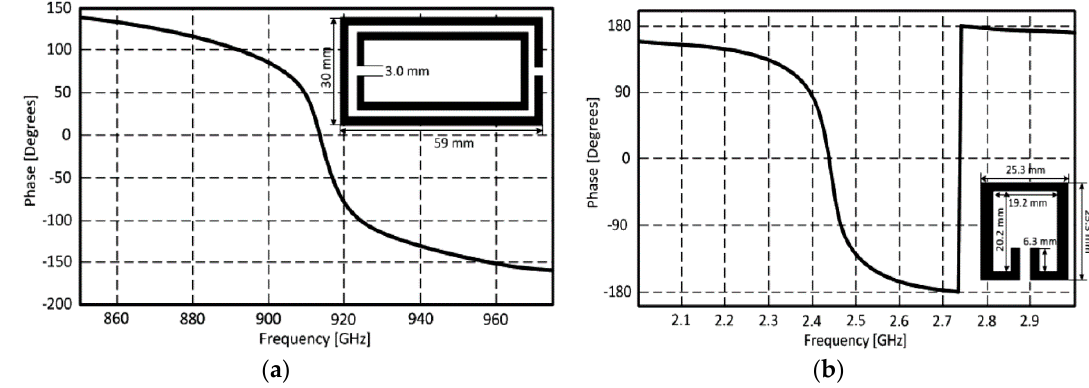
Figure 18. Resonator types for the AMC surface and their phase of the reflected wave: ( a ) Sprit-ring resonator (SRR) and ( b ) single hair pin resonator.